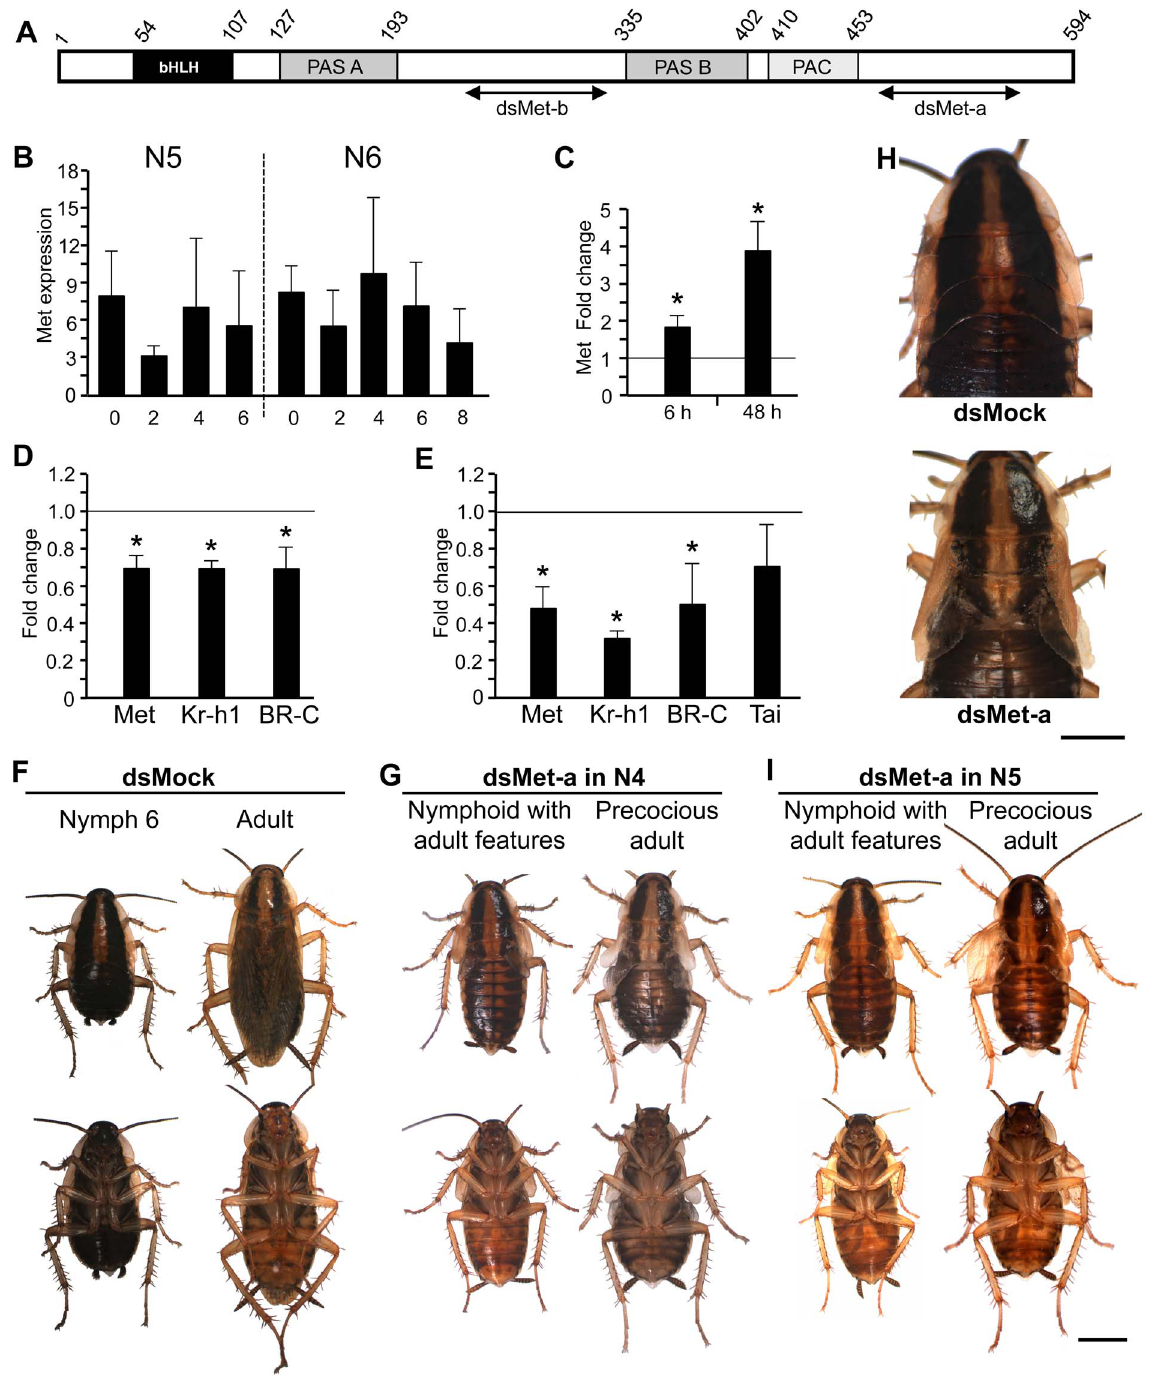
Figure 1. Structure, expression and function of BgMet in Blattellagermanica metamorphosis. (A) Organization of BgMet protein in different domains; also indicated are the regions were the two dsMet used in RNAi studies were designed. (B) Expression of BgMet mRNA in whole body of female nymphs in penultimate (N5) and last (N6) instar. (C) Effect of JH III treatment (20 m g) on BgMet expression; JH was topically applied in freshly emerged N6, and BgMet mRNA levels were measured 6 and 48 h later. (D) Effects, at transcript level, of dsMet-a treatment in N4; N4 females received two 3- m g doses of dsMet-a, one on N4D0 and the other on N4D3, and transcript levels (of Met, Kr-h1 and BR-C) were measured on N4D5; controls received an equivalent treatment with dsMock. (E) Effects, at transcript level, of dsMet-a treatment in N5; the experimental design was equivalent to that used in N4, with a double treatment, one on N5D0 and the other on N5D3; transcript levels (of Met, Kr-h1, BR-C and Tai) were measured on N5D6. (F–I) Dorsal and ventral view of specimens resulting from dsMet-a treatment in N4 and N5; normal last nymphal instar and adult obtained from dsMock treatments, either in N4 or N5 (F); nymphoid (instead of N6) with adult features, and precocious adult obtained from dsMet-a treatments in N4 (G), detail of the enlarged lateral expansions in T2 and T3 of a nymphoid with adult features compared with a control N6 (H), nymphoid with adult features, and precocious adult obtained from dsMet-a treatments in N5 (I). Each point of quantitative data in histograms represents 4 biological replicates and results are expressed as the mean 6 SEM; data in A represent copies of BgMet mRNA per 1000 copies of